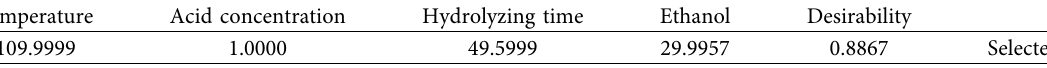
Table 3: The optimized result of bioethanol produced.